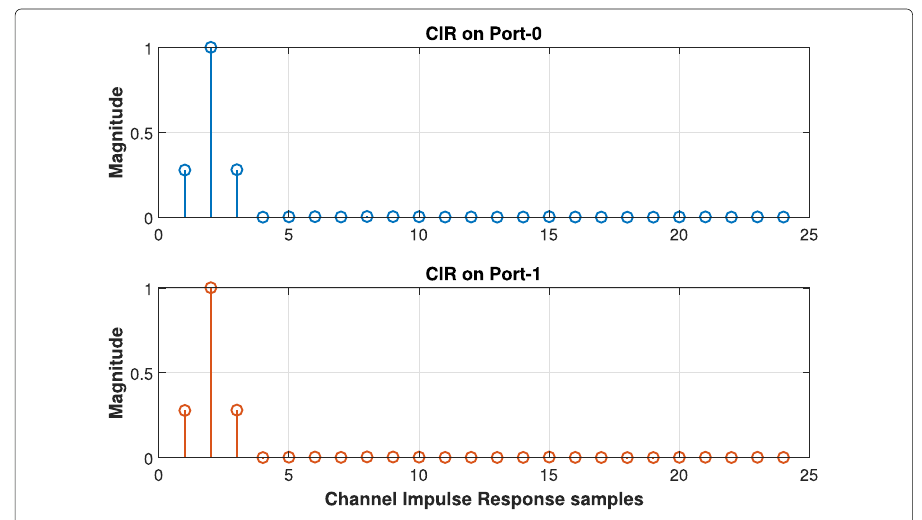
Fig. 13 Magnitude of the estimated channel impulse response on port 0 and port